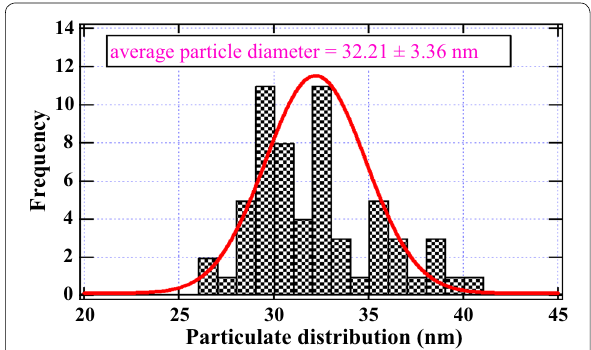
Fig. 2 Particulate size distribution for the co-pyrolysis of croton biodiesel and fossil